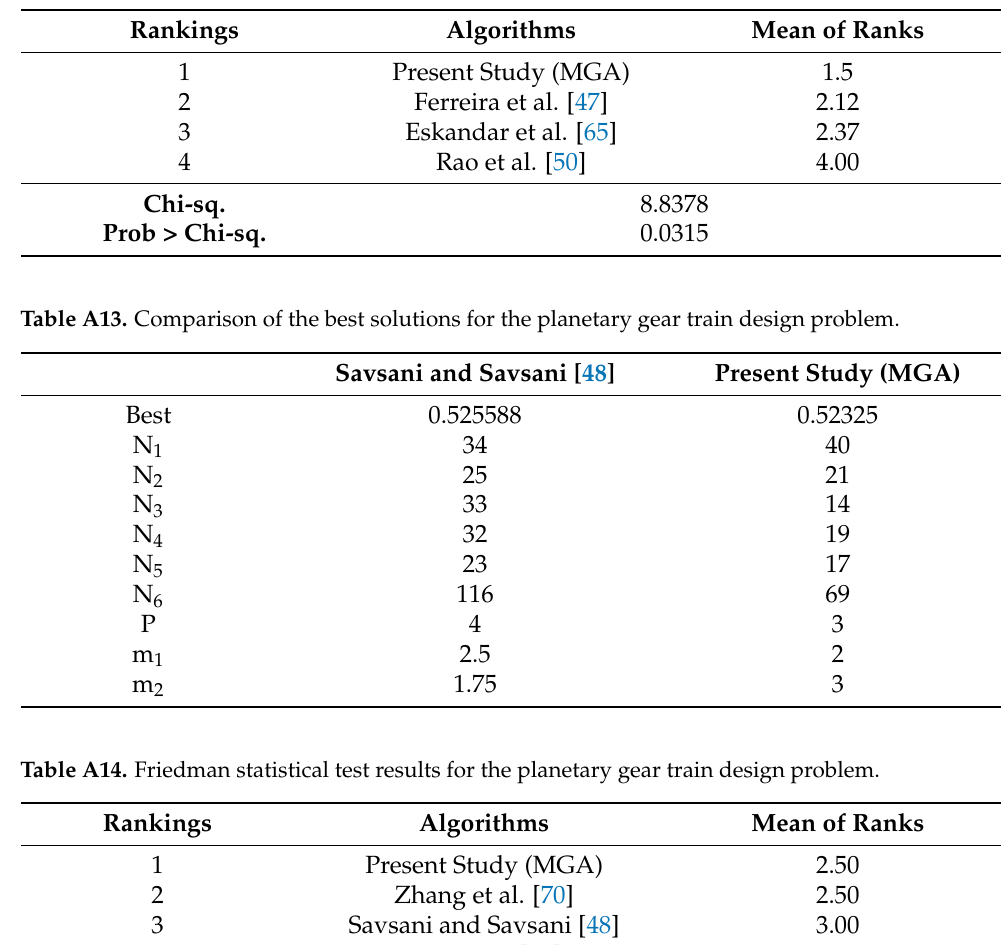
Table A12. Friedman statistical test results for the multiple disk clutch brake design problem.